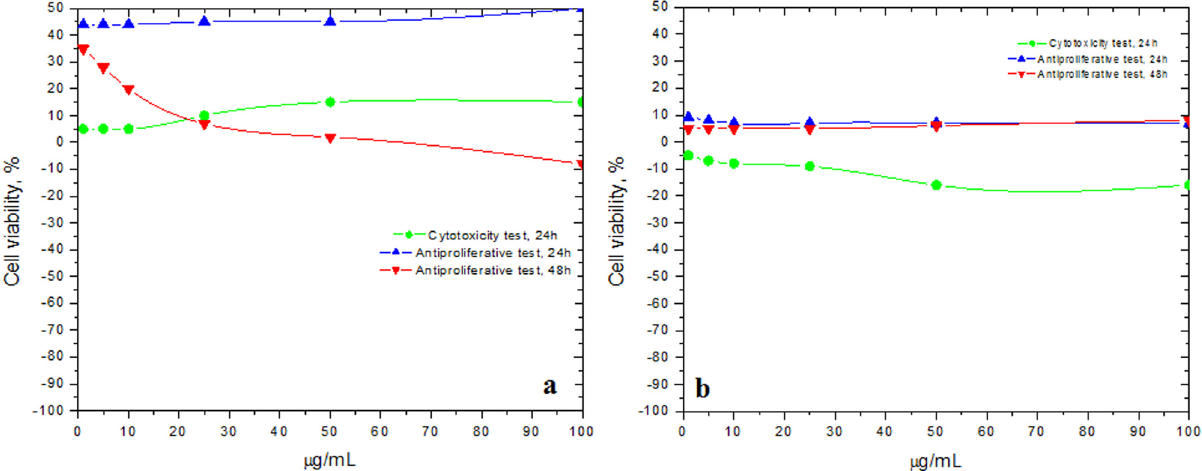
Figure 5: Cytotoxic and antiproliferative e ff ects ( cell viability, % ) of Gpre36 tested on ( a ) mammary gland cell line MCF - 12A and ( b ) human breast tumor cell line BT - 20, compared to the control negative cells; n = 3, ± SD ( % )